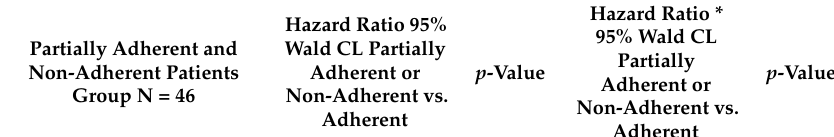
Table 3. Time-to-event outcomes from randomization through end of follow-up in group receiving hybrid comprehensive telerehabilitation by the degree of patients’ adherence to